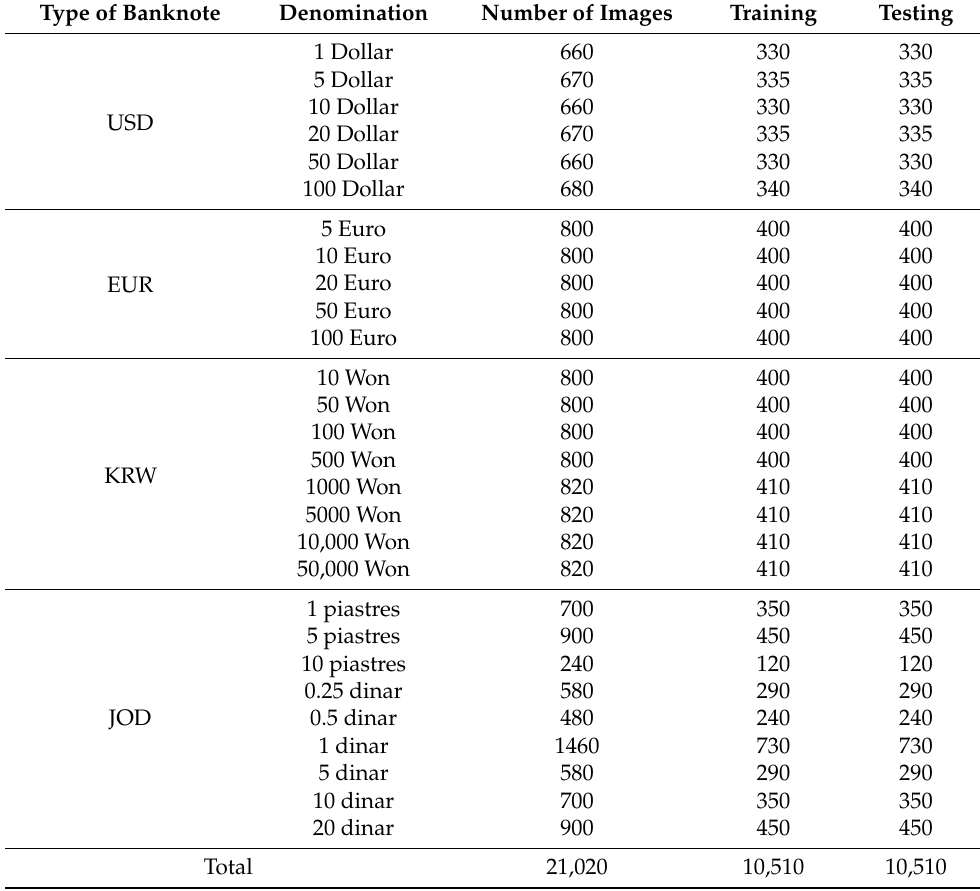
Table 3. Detailed description of